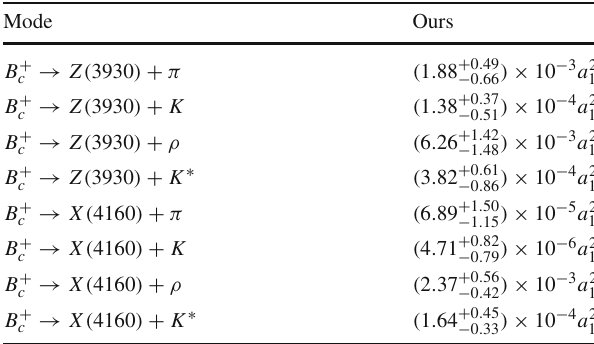
Table 2 The decay widths of exclusive nonleptonic decays of B c to Z ( 3930 ), X ( 4160 ) (in 10 − 15